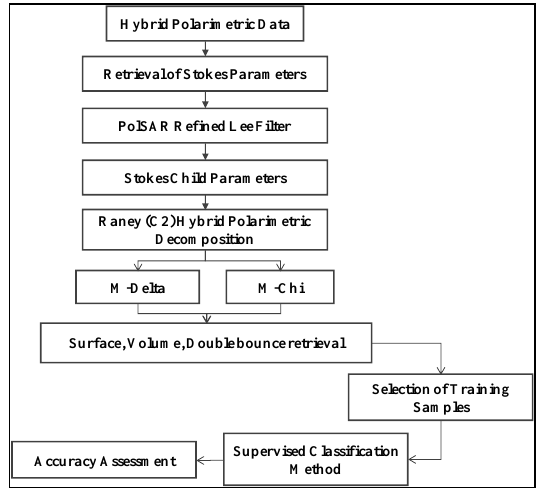
Figure 1 : Methodology flowchart – Polarimetric decompositions - Classification